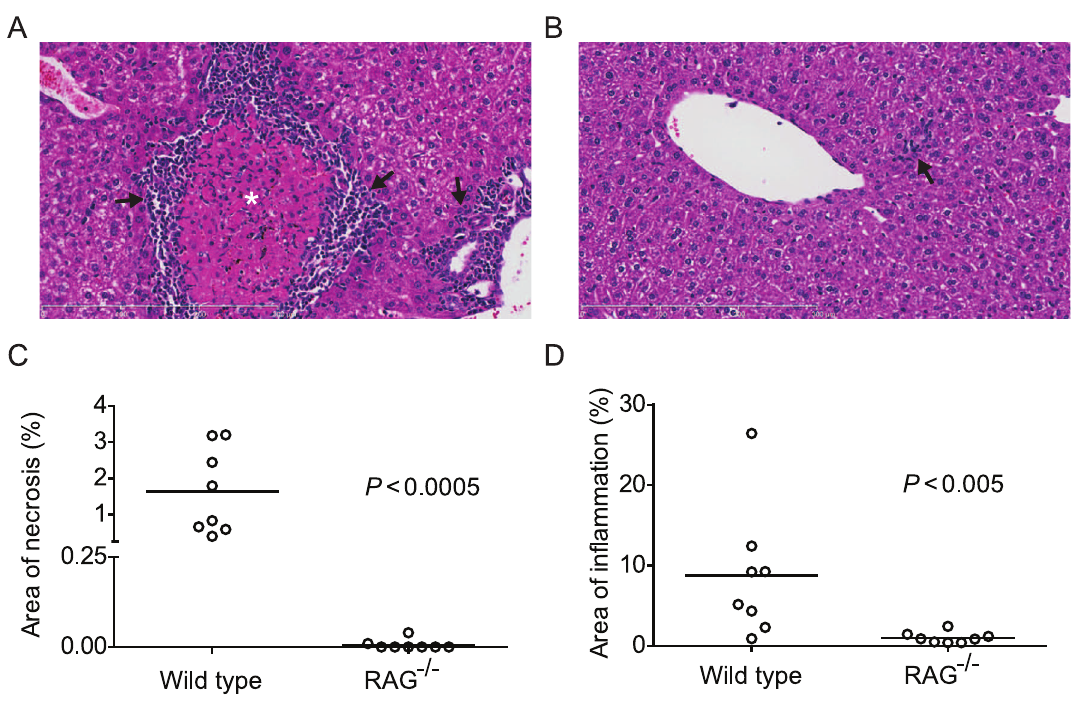
Figure 1. Pre-patent S.mansoni infection does not induce liver necrosis and inflammation in RAG 2 / 2 mice. Wild type (C57BL/6) and RAG 2 / 2 mice were infected with S. mansoni cercariae via percutaneous tail exposure and livers were removed for histological analysis at 4 weeks p.i. (A) Representative H&E-stained liver section from a wild type mouse, exhibiting inflammatory cell infiltration (arrows) in periportal area and surrounding a focus of coagulative necrosis ( ! ). (B) Representative H&E-stained liver section from a RAG 2 / 2 mouse. Note small and isolated cluster of inflammatory cells (arrow). (C) Average percent area of tissue section occupied by coagulative necrosis was calculated for each animal (n=8, pooled from two independent experiments). Horizontal bars represent mean values for each experimental group. (D) Average percent area of tissue section occupied by inflammatory infiltrate was calculated for each animal (n=8, pooled from two independent experiments). Horizontal bars represent mean values for each experimental group. P values were determined using the Mann Whitney test. Scale bars in A and B are 300 m m in